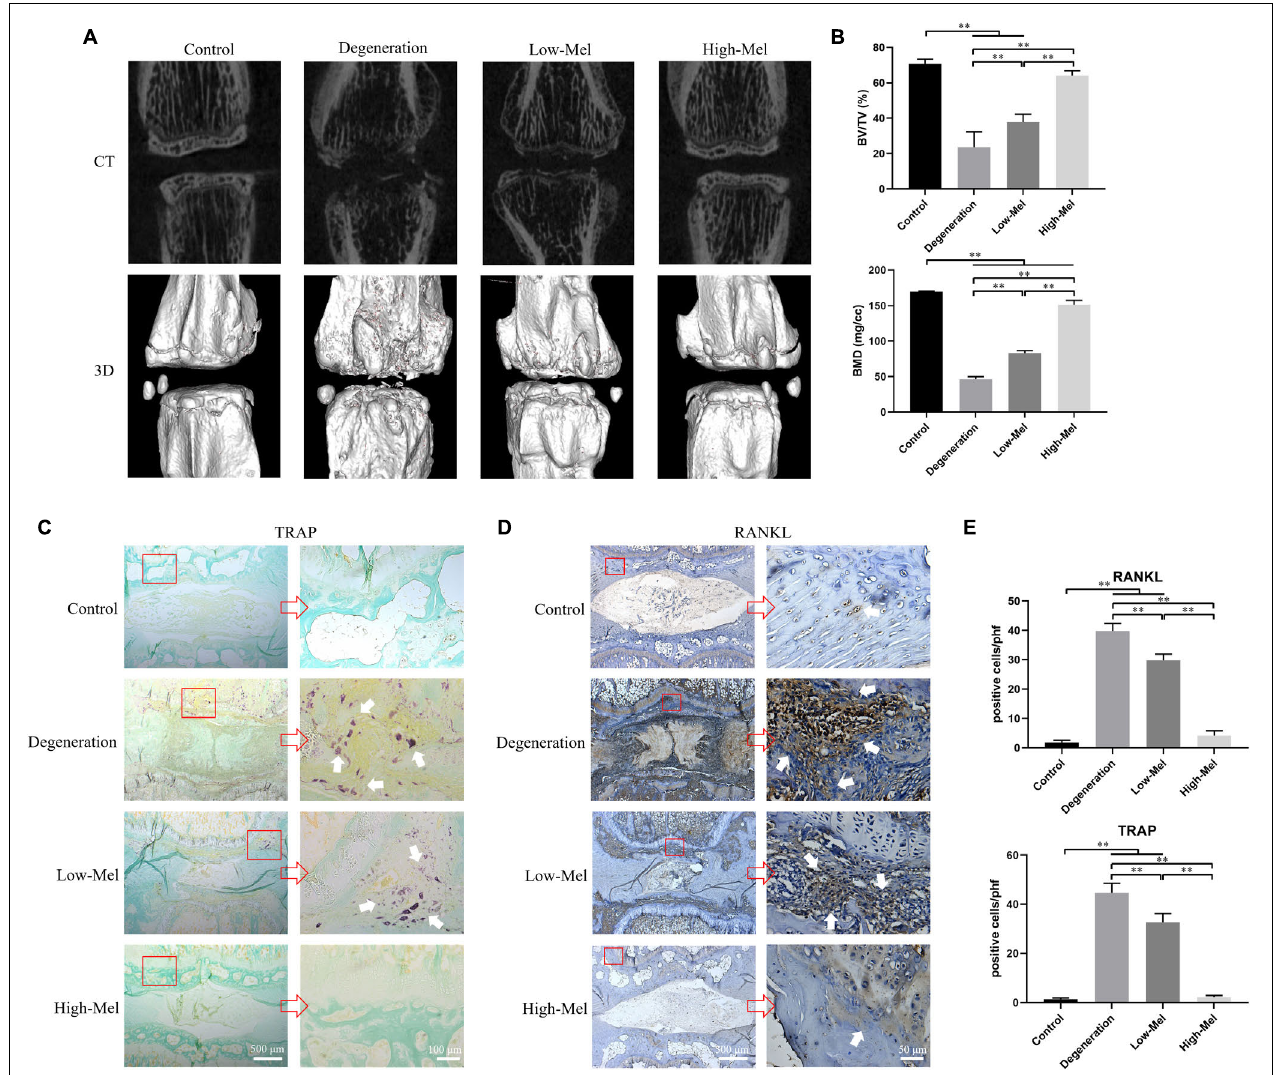
FIGURE 3 | Melatonin (Mel) inhibited the destruction of endplate (EP) and reduced subchondral bone loss. (A) Micro-CT images and 3D surface reconstruction of rat caudal vertebrae among different groups on the 7th day. (B) Micro-CT analysis of specific indicators: bone volume to tissue volume (BV/TV) and bone mineral density (BMD). (C) Tartrate-resistant acid phosphatase (TRAP) staining of rat coccygeal intervertebral disk (IVD). (D) Immunohistochemical staining of receptor activator for nuclear factor- κ B ligand (RANKL) in rat coccygeal IVD. (E) Quantitation of TRAP-positive cells and RANKL-positive cells among different groups ( n = 5, ∗ P < 0.05, ∗∗ P <